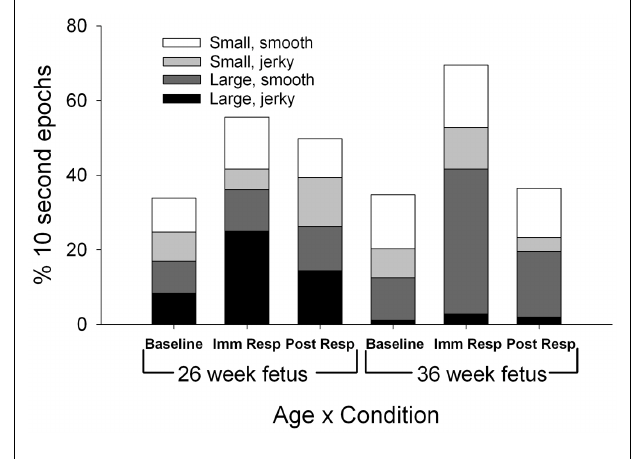
FIGURE 4 | Each column represents the average percentage of 10-s epochs for total limb movements (large, jerky; large smooth; small jerky; small, smooth) observed at 26 (columns 1–3) and 36weeks gestation (columns 4–6). For illustration, at both the 26 and 36week assessment, both large limb jerky (black) and large limb smooth (light gray) increased from baseline to immediate response ( F (1,11) = 8.91, p = 0.012 and F (1,11) = 6.64, p = 0.026).